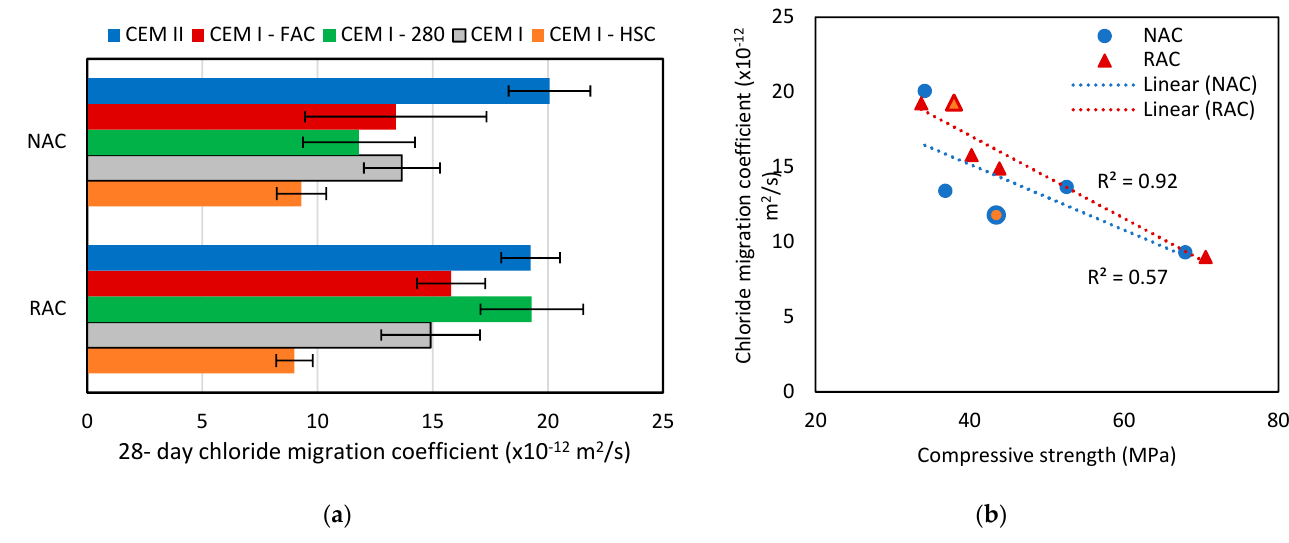
Figure 4. Chloride migration coefficient: ( a ) 28-day chloride migration coefficient of all mixes; ( b ) Correlation between 28-day compressive strength and 28-day chloride migration coefficient. CEM I: 280 mixes represented with a yellow fill.